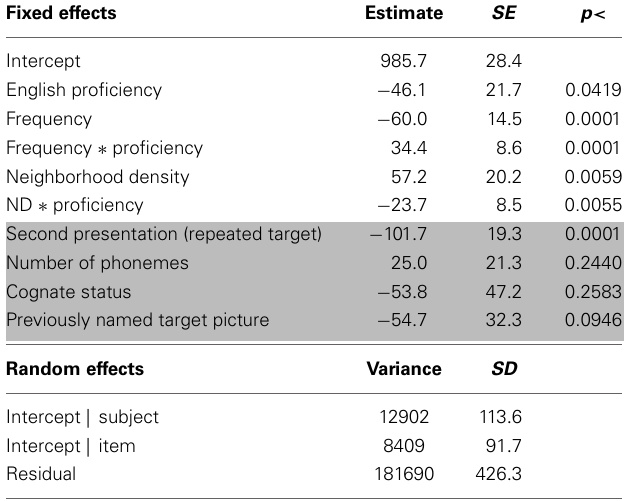
Table 3 | Results for the analysis of peak dilation latencies—bilingual participants.